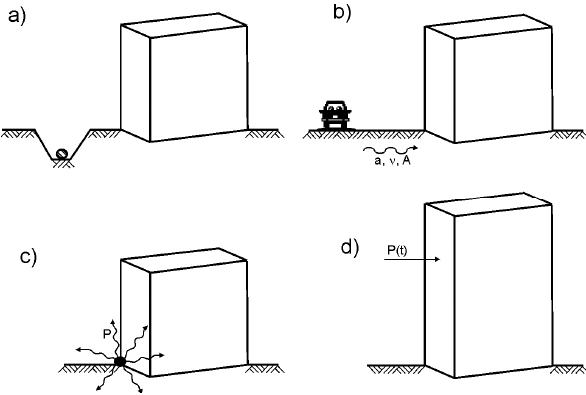
Fig 1 . Special loads of building structures: a) changes in subsoil, b) vibrations, c) explosions, d)